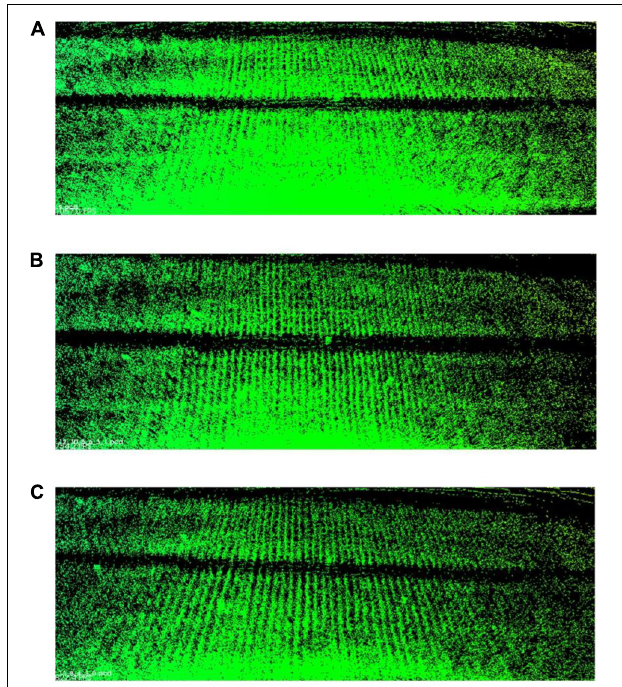
FIGURE 15 | Merged clouds for three different steps. (A) Is the merged cloud for “step = 1”; (B) is the merged cloud for “step = 2”; (C) is the merged cloud for “step =